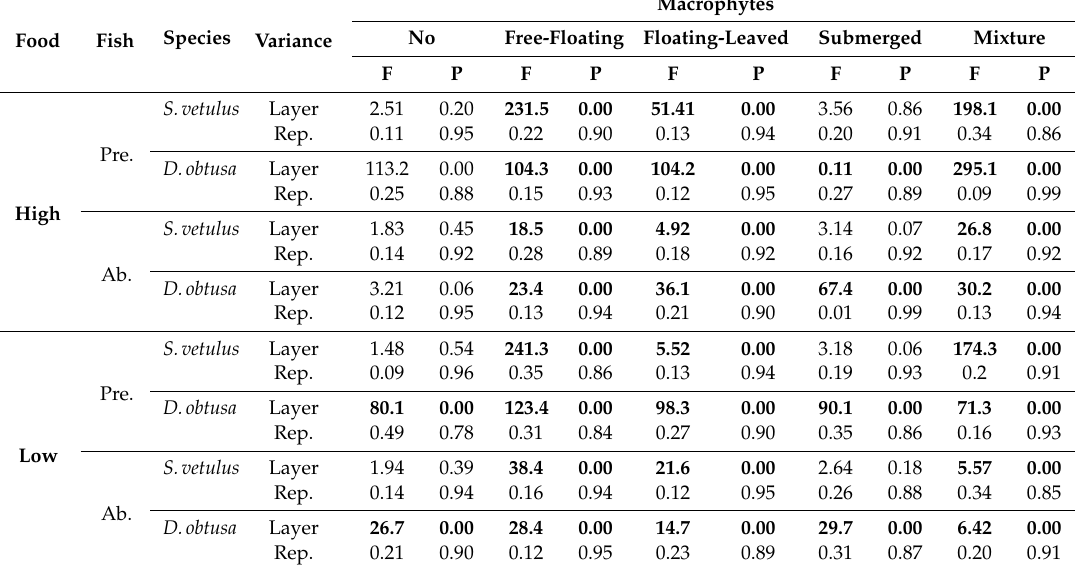
Table 3. One-way nested ANOVA results for the e ff ects of main groups (d.f, 3; shown as layer in the table; surface, upper, lower, and bottom) and subgroups (d.f, 9; shown as replicates in each of microcosm experiment) on two Cladocera species in association with three factors (macrophyte types, fish kairomones, and food availability in microcosm experiment). Pre., presence; ab. absence; Rep. replicates. Bold letter indicate values that are statistically